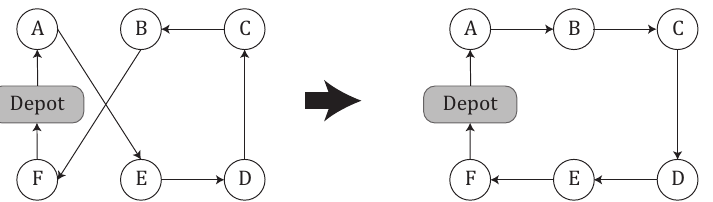
Figure 1. Example of 2-opt move between B and E nodes, which implies that edges AE and BF are removed and edges AB and EF are inserted.